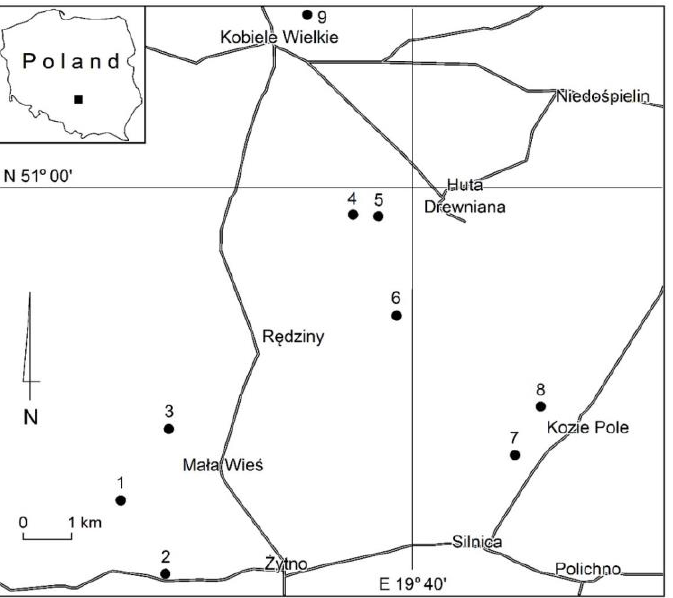
Figure 1. Map of the research area. The numbers represent the locations of the studied reservoirs. Locations 1 and 2 are the control (natural) lakes, and locations 3 to 9 are the post-exploitation reservoirs. Swamps and peat bogs developed in the depressions between the dunes. The de- posited peat layers, exploited mainly at the turn of the nineteenth and twentieth centuries, were used as fuel. After the end of exploitation, the pits were flooded, resulting in the formation of reservoirs (Figures 2–4).